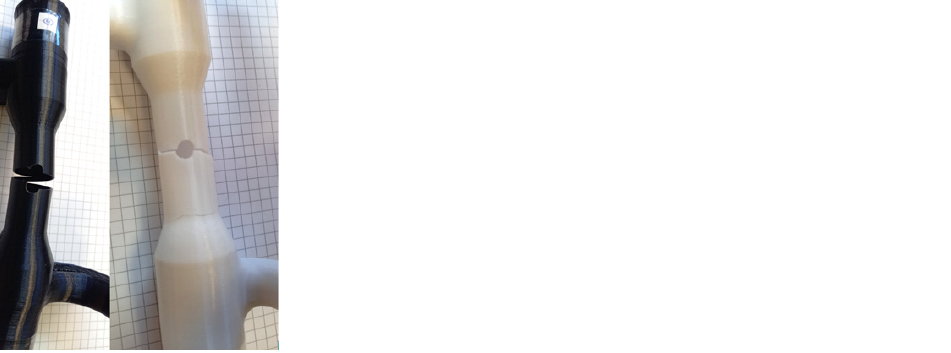
Figure 20. Post-test photograph of combined loading specimens (left specimen fabricated using Ultimaker© and right specimen fabricated using Fortus©).